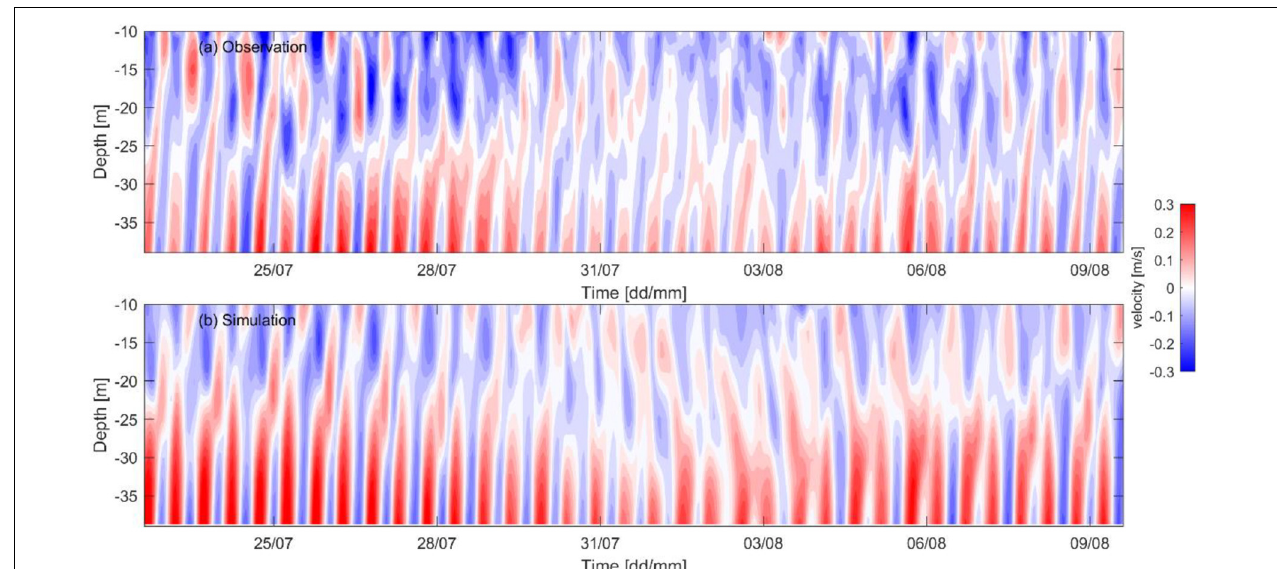
FIGURE 4 | The filtered baroclinic current component below 10 m depth for (a) observation and (b) simulation at the mooring site from July 23 to August 10, 2017. The component is computed along the major axis of the flow, which have the positive values at 30 ◦ toward north-east.